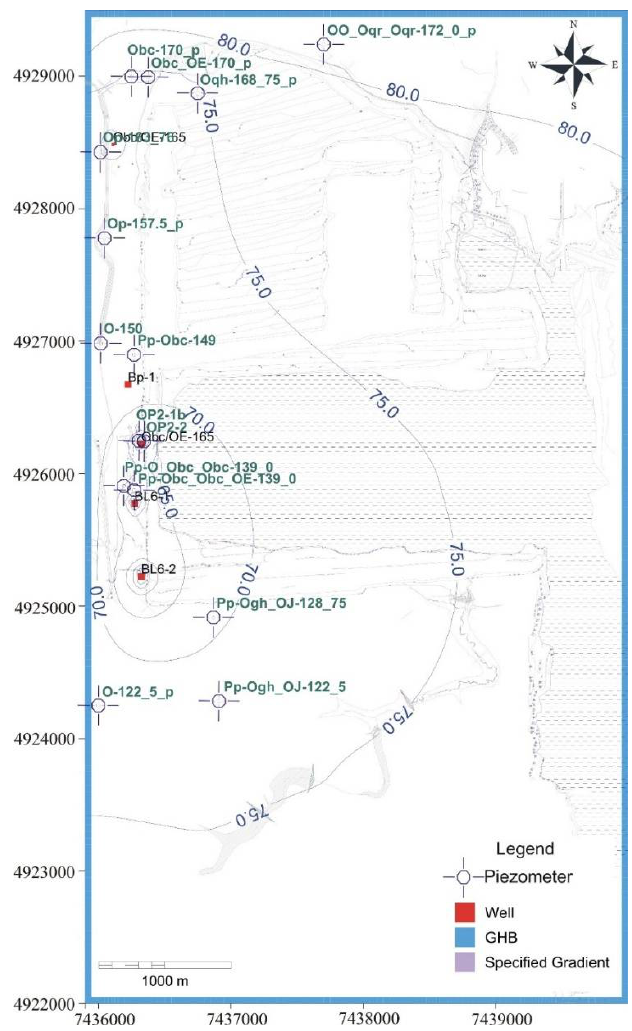
Figure 13. Groundwater levels of the lower aquifer (7th modeled layer)—September 2014.